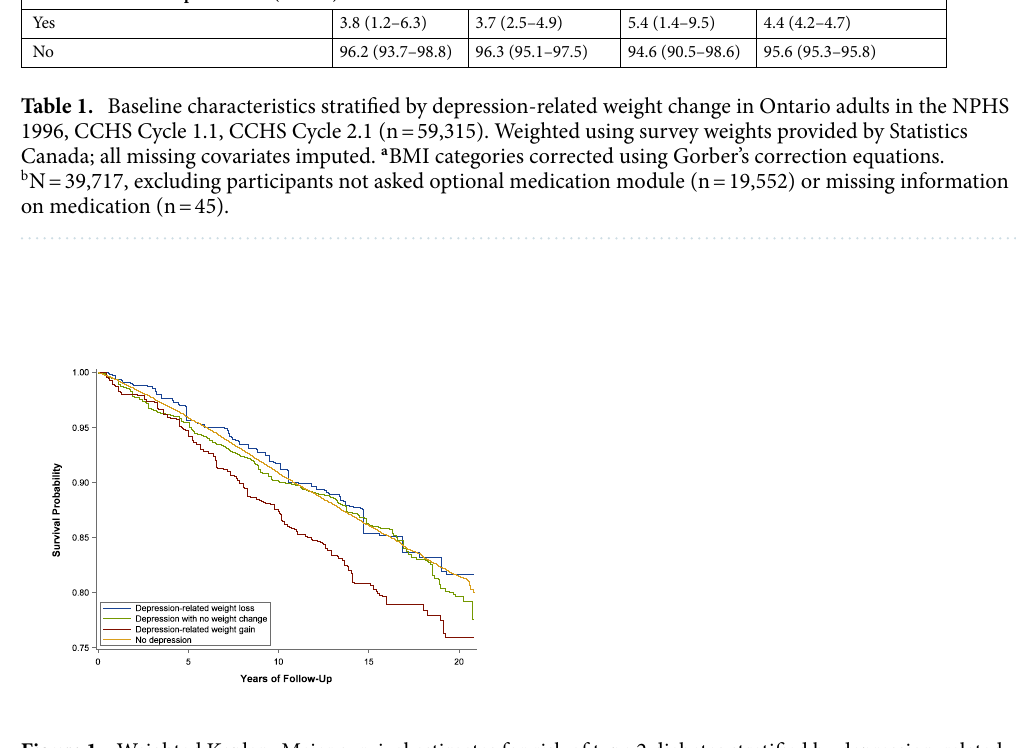
Figure 1. Weighted Kaplan–Meier survival estimates for risk of type 2 diabetes stratified by depression-related weight change for Ontario adults in the NPHS 1996, CCHS Cycle 1.1, CCHS Cycle 2.1 (n = 59,315).